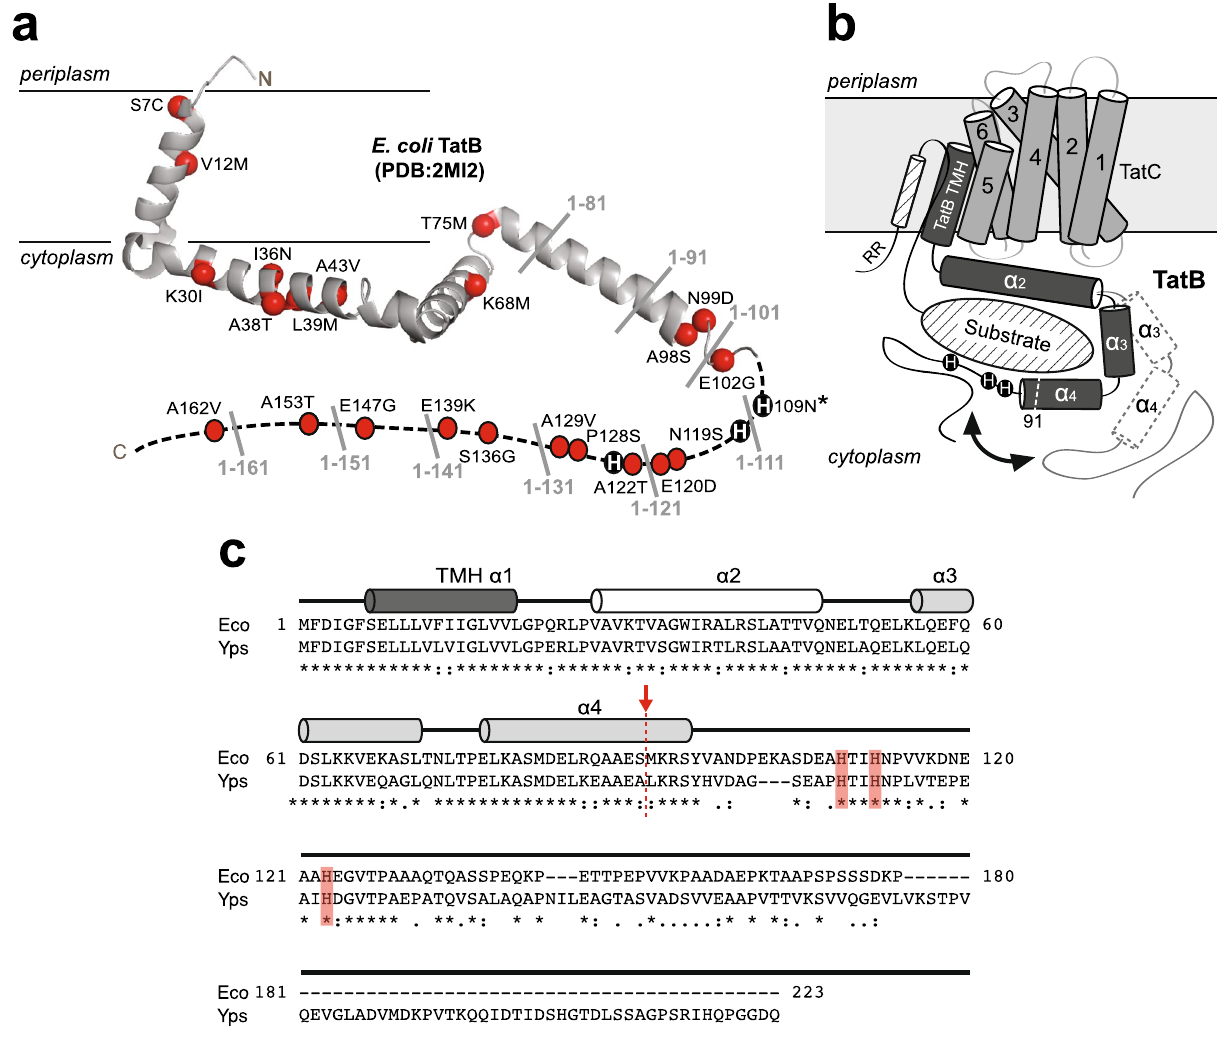
Figure 1. Structure of TatB translocase component. ( a ) Ribbon diagram of the solution structure of TatB 1–101 adapted from Zhang et al. 31 . QCS substitutions isolated by Rocco et al. 26 are marked as red balls (except for H109N which is marked with asterisk). Locations of truncation sites in 10-residue increments from the C-terminus are labeled in gray. Histidines at positions 109, 112, and 123 are shown as black circles. ( b ) Model of possible TatB-substrate interactions adapted from Ulfig et al. 35 . The framed light gray box represents the lipid bilayer, while a TatC monomer is depicted by six transmembrane helices, and a TatB monomer is depicted with a membrane-embedded transmembrane helix (TMH α1), a strongly amphipathic helix (α2), and two highly hydrophilic and flexible helices (α3 and α4). The cytosolic α3 and α4 helices encapsulate a folded substrate protein (diagonal hatched oval), with possible movement of the helices depicted by black arrow and dashed line cylinders. It should also be pointed out that the TatBC complex functions as a receptor for the N-terminal signal peptide, which is defined by a twin-arginine motif (RR) and h-region α-helix (diagonal hatched cylinder). For clarity, the cartoon does not account for the well-known signal peptide-TatBC interaction. Also, for clarity, only one TatB monomer (dark gray) and one TatC monomer (light gray) are shown, but the model could easily accommodate higher order oligomeric structures such as the tetrameric TatBC complex described by Lee et al. 36 . One possible scenario for QC could be that upon binding of the signal peptide and N-terminal part of the substrate, the C-terminal domain of TatB dynamically wraps around the substrate and performs conformational proofreading. ( c ) Multiple sequence alignment of TatB proteins from γ-proteobacteria E. coli and Y. pseudotuberculosis generated using CLUSTALW. Asterisks indicate identical amino acids, colons indicate conservation between amino acids with strongly similar properties, and periods indicate conservation between amino acids with weakly similar properties. The α-helical regions were determined previously by solution NMR spectroscopy 31 and are represented here as cylinders. The truncation point after residue 91 is marked with red arrow/dashed line and the histidines at positions 109, 112, and 123 are shaded